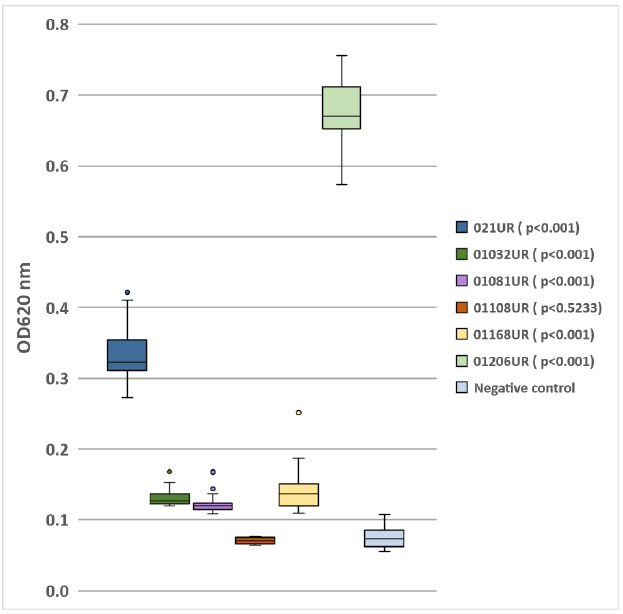
Figure 1. Biofilm formation by E.coli isolated from patients’ urine samples.